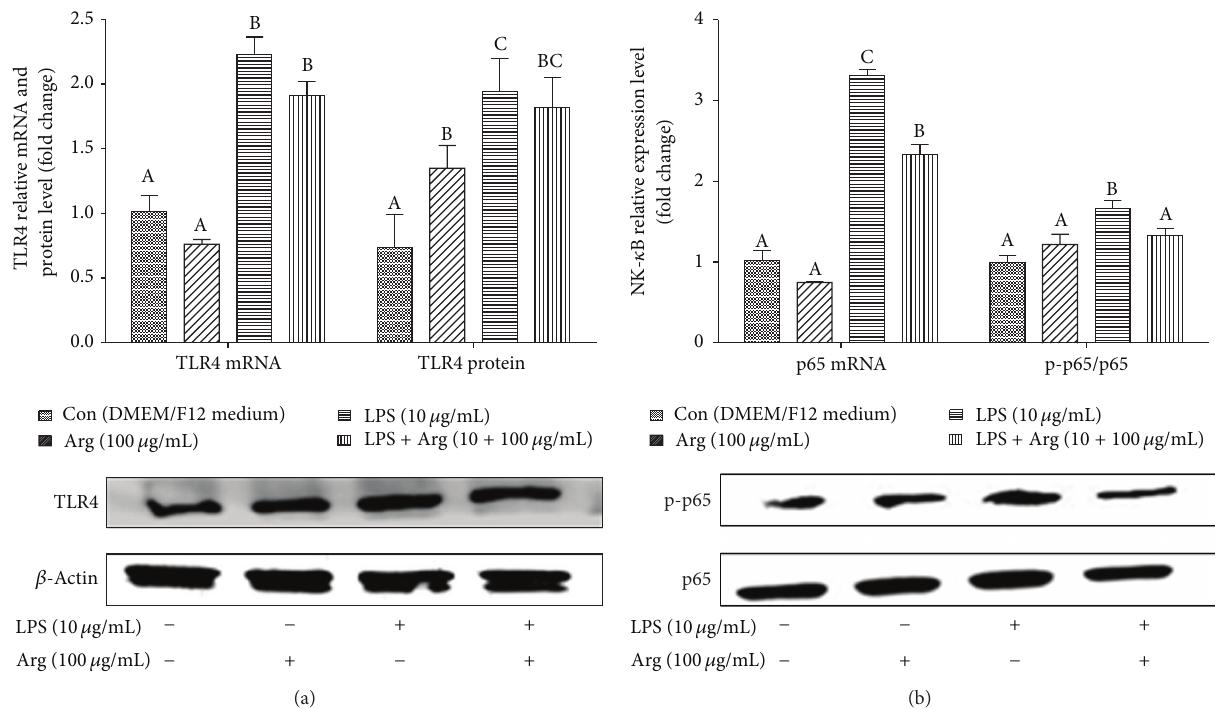
Figure 2: The effect of Arg on LPS-induced TLR4, NF- 𝜅 B mRNA, and protein expression in BMECs. Pure 2nd generation BMECs were starved for 16h and then cultured in DMEM/F12 medium containing 0 or 10 𝜇 g/mL LPS and 0 or 100 𝜇 g/mL Arg. After 12h, the mRNA levels of TLR4 and NF- 𝜅 B were analyzed using qPCR. Protein expression was analyzed using western bolt. 𝛽 -Actin was used as an internal reference. Data shown are mean ± SEM of three independent experiments. Means with different letters (A, B, or C) are significantly different ( 𝑃 < 0.05 ) from each other.